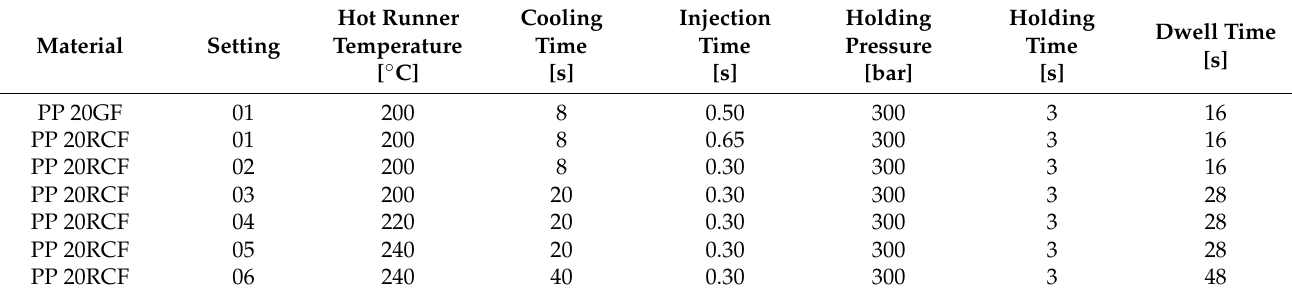
Table 4. Process parameters of injection